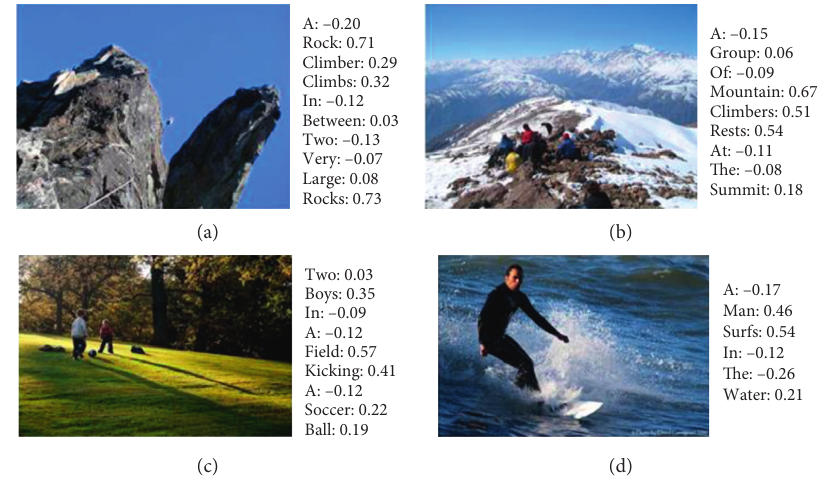
Figure 6: Similarity matching between image and